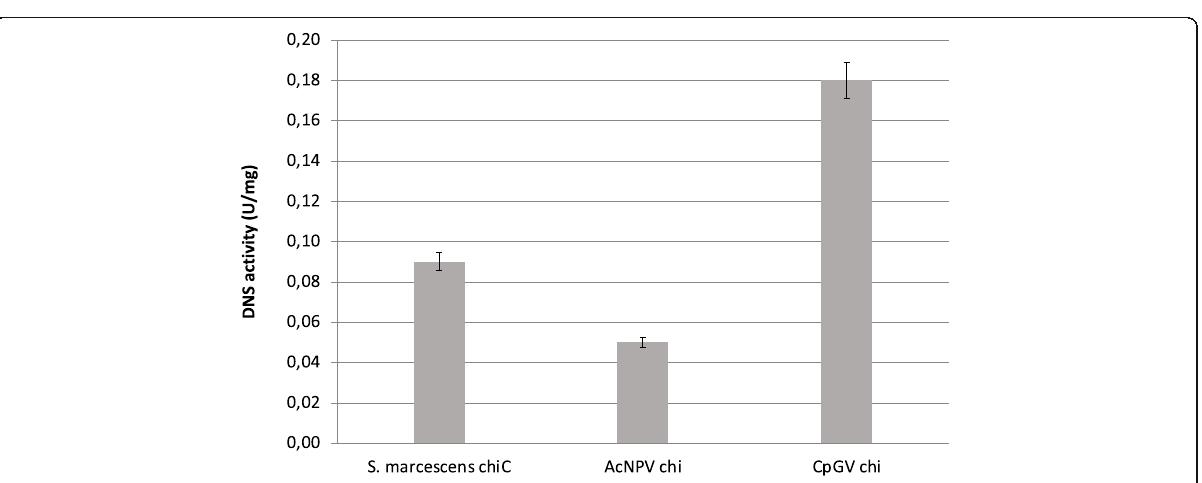
Fig. 4 Hydrolyzing activities of Serratia marcescens -ChiC, AcNPV-Chi, and CpGV-Chi proteins against colloidal chitin